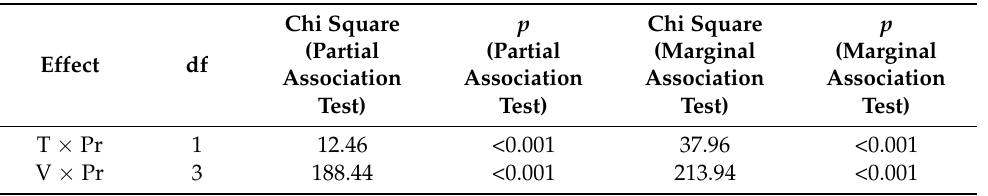
Table 6. Log linear results showing the effect of each factor (T = treatment; V = vineyard) on predation rate (Pr = predation rate).